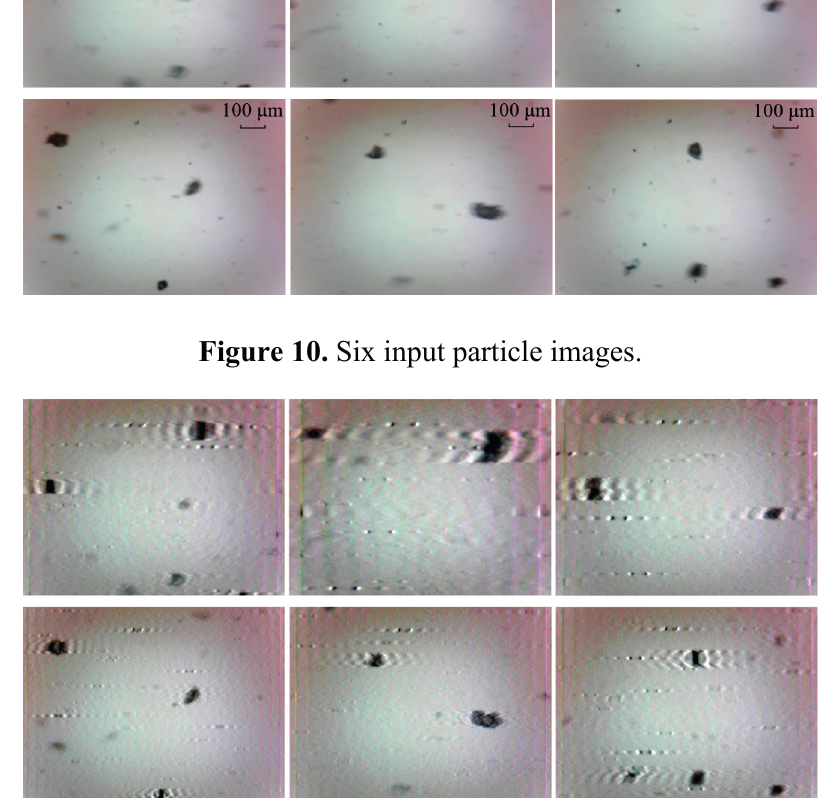
Figure 11. Restored results based on the whole